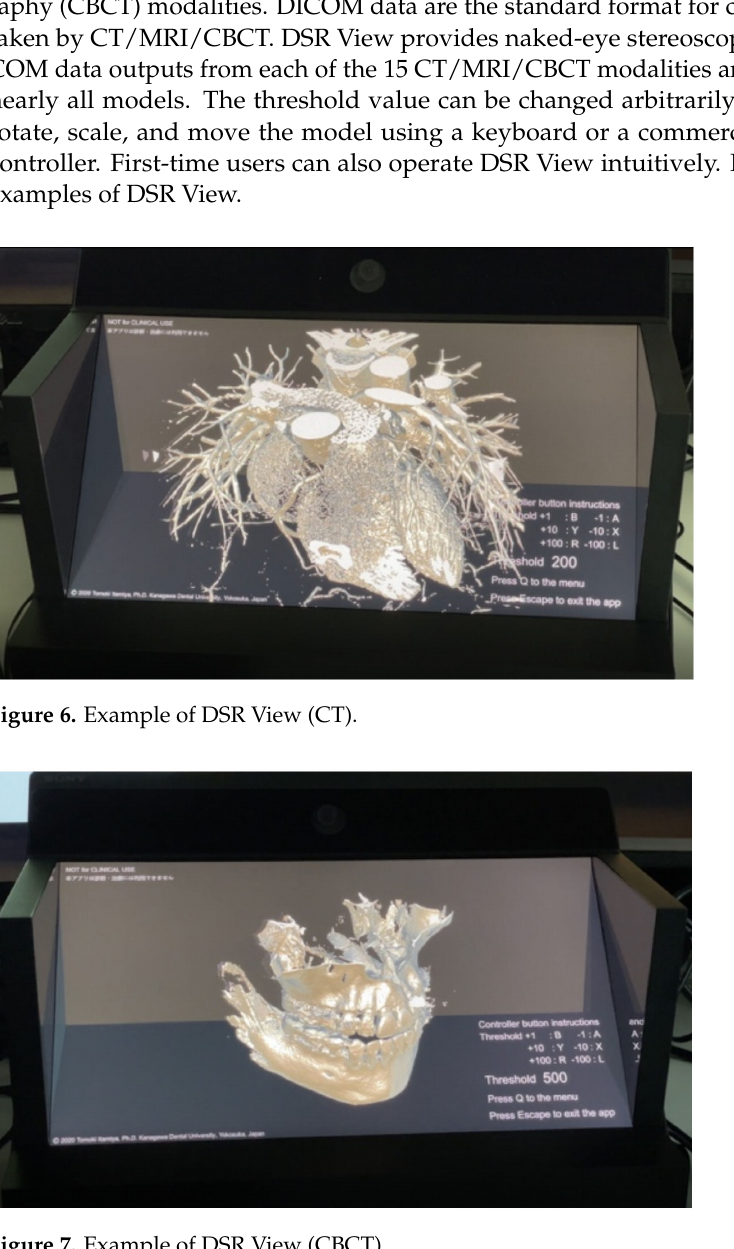
Figure 7. Example of DSR View